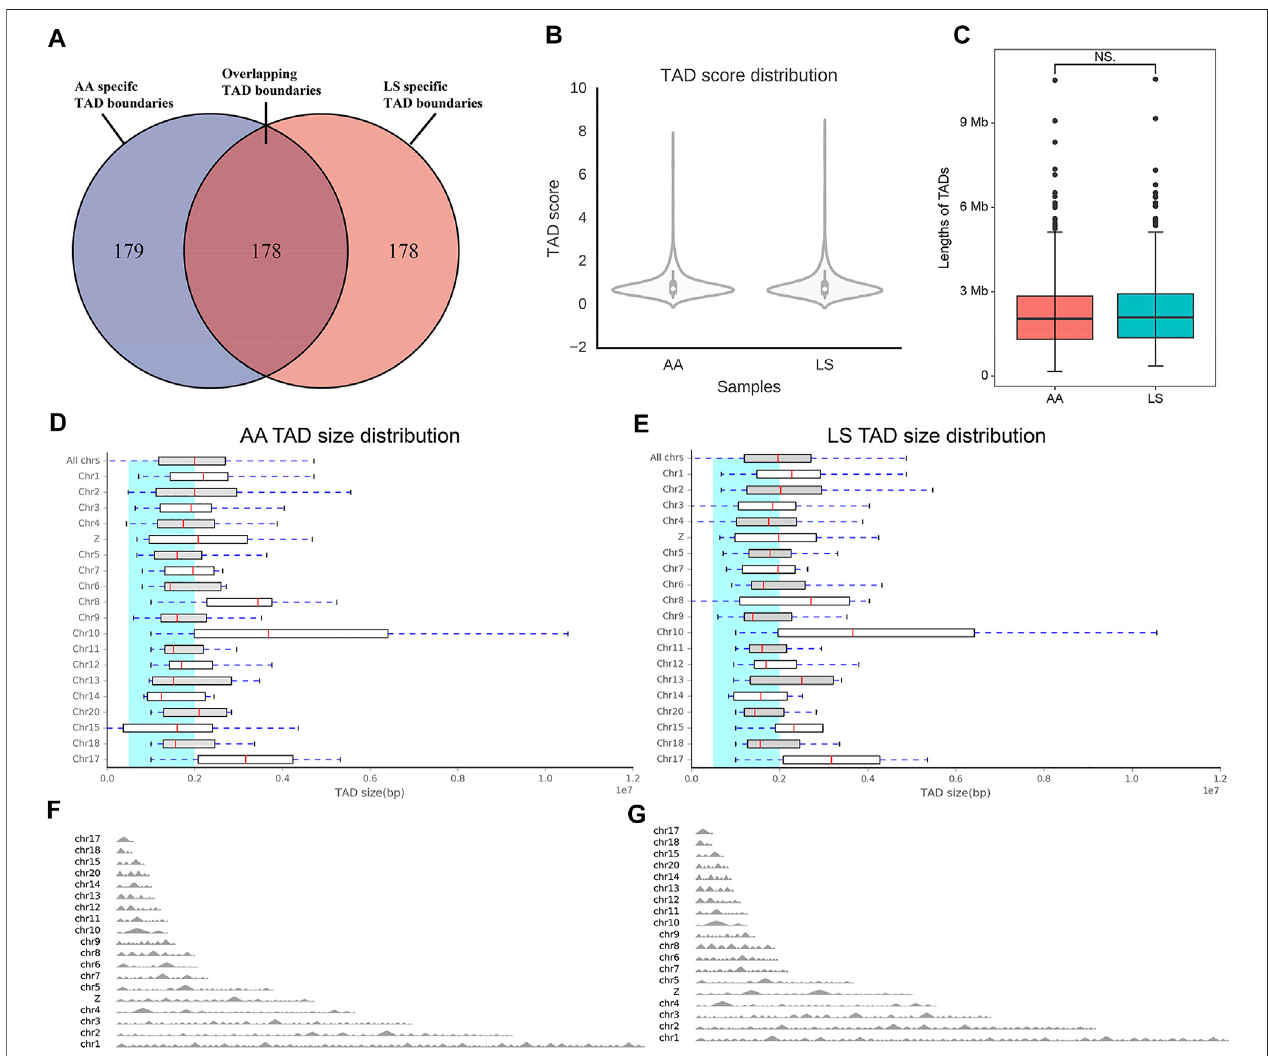
FIGURE5| ComparativeanalysisofTADbetweenAAandLSchickenbreastmuscles. (A) Venndiagramshowingthat (cid:1) 50%ofalltheTADboundariesbetweenAA andLSchickenbreastmusclesareconserved. (B) TADscoredistributionofAAandLSchickenbreastmuscles. (C) DifferencesinthelengthsofTADbetweenAAandLS chicken breast muscles. (D,E) TAD size distribution of AA and LS chicken breast muscles, respectively. (F,G) TAD distributions on all chromosomes of AA and LS chicken breast muscles, respectively.